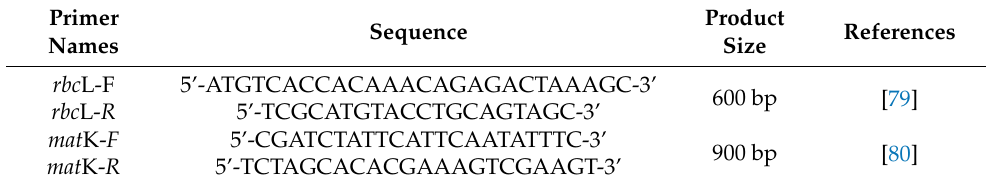
Table 5. Primer names, sequences, and product sizes for the rbc L and mat K genes’ DNA